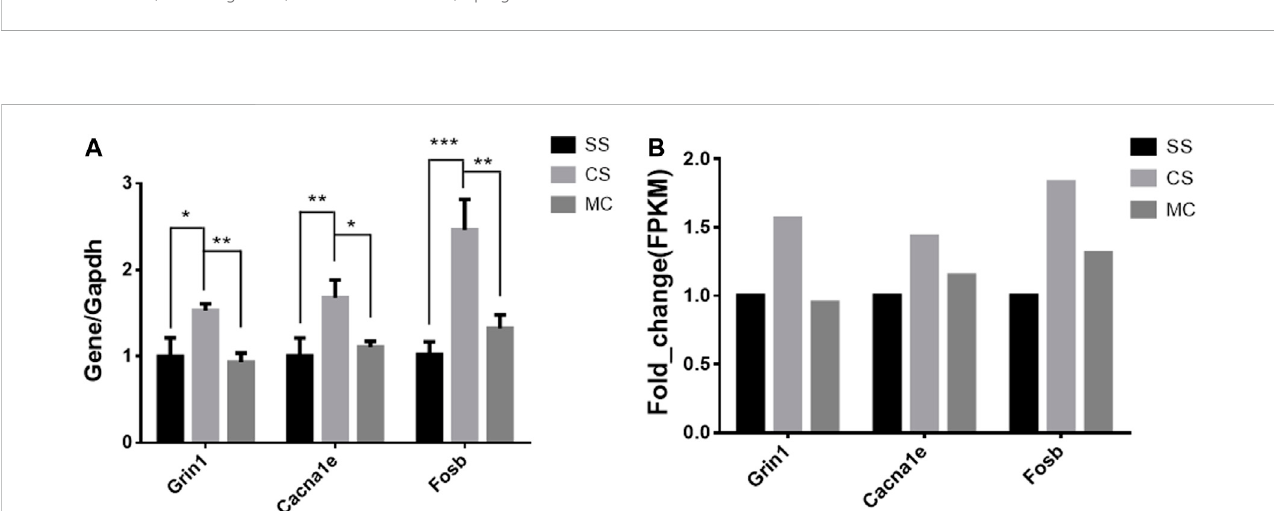
FIGURE 8 Gene regulatory network incorporating DEGs – TFs – miRNAs regulated by cocaine and reversed by MET. Diamonds, DEGs; Vs, TFs; ellipses, miRNAs. Green and blue, downregulated; red and darksalmon, upregulated.